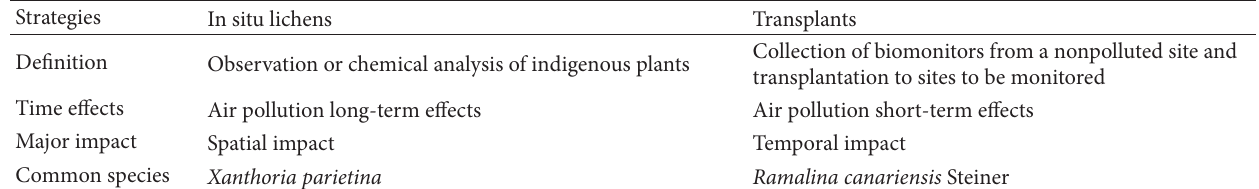
Table 6: Main features of the different strategies of lichens